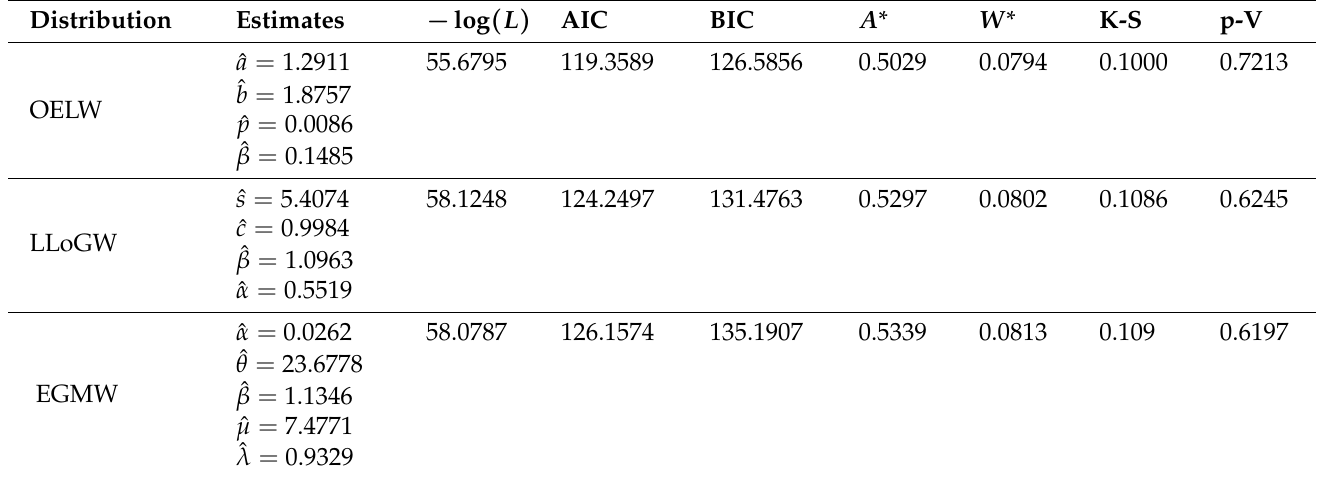
Table 4. Estimated values, log-likelihood, AIC, and BIC for the survival data